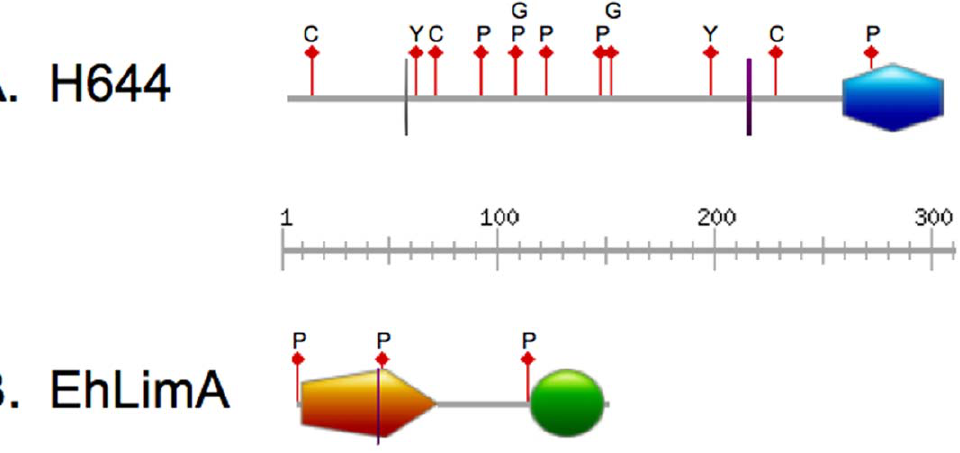
Figure 3. Schematic of domains found in the hypothetical protein H644 and EhLimA. A. H644 is a hypothetical protein with a postulated molecular weight of 33.8 kDa (304 amino acids). It is predicted to have a lysine-rich region (blue hexagon), a glycosylation site (gray vertical line), a N- myristoylation site (purple vertical line), 3 casein kinase II phosphorylation sites (red flags labeled C), 5 protein kinase C phosphorylation sites (red flags labeled P), 2 tyrosine kinase phosphorylation sites (red flags labeled Y), and 2 cAMP/cGMP-dependant protein kinase phosphorylation sites (red flags labeled G). B. EhLimA has a molecular weight of 15.9 kDa (145 amino acids). It has an N-terminal LIM domain (orange pentagon), a C-terminal glutamic acid-rich region (green circle), 3 protein kinase C phosphorylation sites (red flags labeled P), and a N-myristoylation site (purple vertical